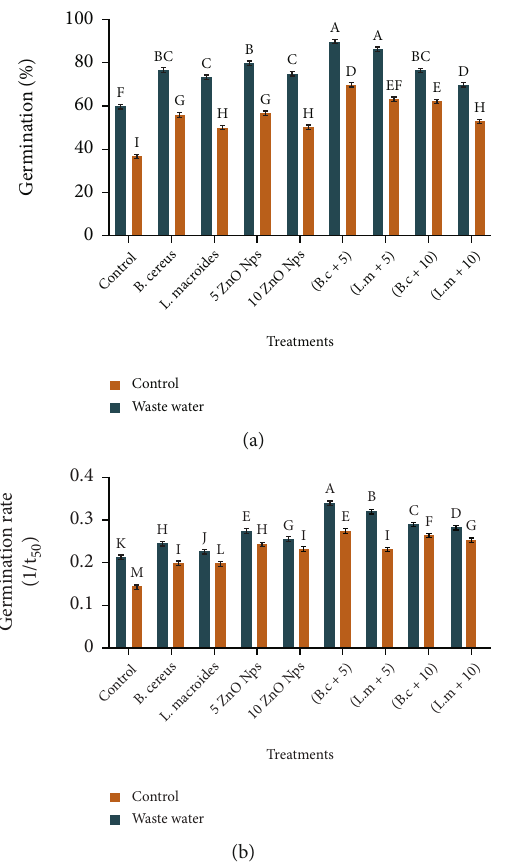
Figure 1: Synergistic e ff ect of bacterial strains ( Bacillus cereus and Lysinibacillus macroides ) and ZnO NPs (5 and 10mg/L) treatments on (a) germination % and (b) germination rate of rice grown in heavy metal-contaminated water. Error bars showed means of standard error ( ± SE) of three replicates ( n = 3 ) followed by di ff erent alphabetic letters showing statistical signi fi cance at 5% probability level. Control (distilled water), B.C+5 ( Bacillus cereus +5mg/L ZnO NPs), L.M+5 ( Lysinibacillus macroides +5 mg/L ZnO NPs), B.C+10 ( Bacillus cereus +10mg/L ZnO NPs), and L.M +10 ( Lysinibacillus macroides +10mg/L ZnO NPs).